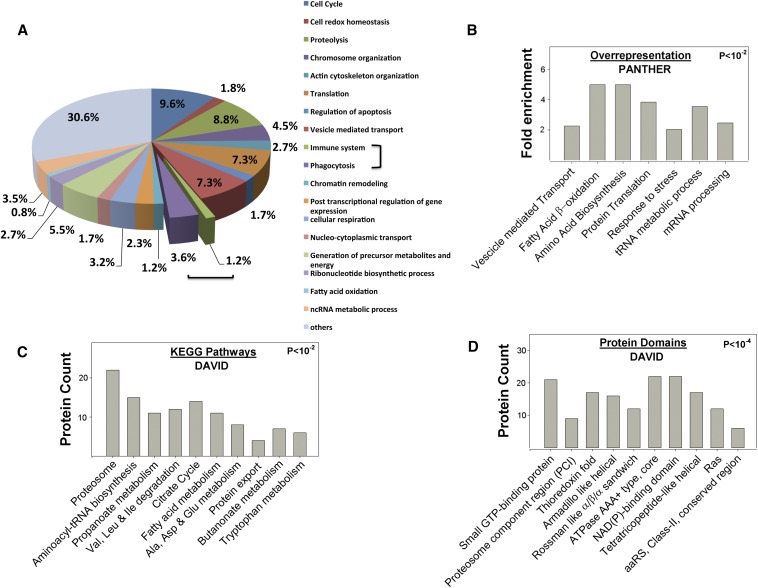
Analysis of the confident set. (A) A confident data set of 710 proteins, which is a subset of the 1619 unique proteins identified in the experiment, was used for Gene Ontology analysis using David Bioinformatics resource, where proteins are classified into various functional groups. Including phagocytic function, 4.8% of the proteins could be related to a function in immune response. (B) Fold enrichment, based on a statistical overrepresentation test, normalized to a standard Drosophila data set, for few of the cellular processes with a P < 0.01. The PANTHER (Mi and Thomas 2009) resource is used to calculate the values, as described in Materials and Methods. The P values for the categories represented increases from left to right, with Vesicle transport having the value of 4.3 × 10−5. 621 proteins from the confident set are analyzed by the program (n = 621). (C) Number of proteins that show significant enrichment, normalized to a standard Drosophila data set, for functional pathways, as analyzed by the KEGG module of the DAVID bioinformatics resource (Huang da et al. 2009b). The P values are as calculated by the program (see Materials and Methods) and are ordered with increasing value from left to right, ranging from 4.0 × 10−8 (Proteasome) to 8.3 × 10−2 (Tryptophan metabolism), n = 249. (D) Number of proteins that show significant enrichment, normalized to a standard Drosophila data set, for protein domains, as analyzed by the DAVID bioinformatics resource (Huang da et al. 2009b). The P values are as calculated by DAVID (see Materials and Methods), range from 1.5 × 10−7 (Small GTP-binding proteins) to 9.8 × 10−4 (aaRS, class2 ), n = 614.